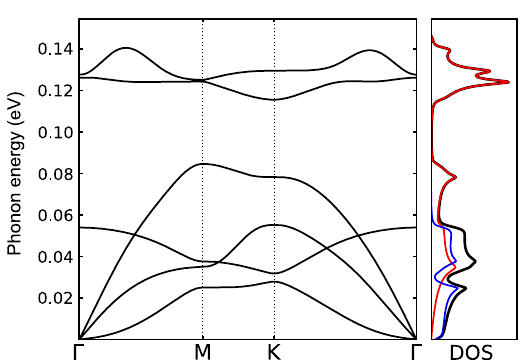
Figure 4. The phonon band structure of 2D-SiC and the corresponding density of states (in-plane and out-of- plane components are shown in red and blue,